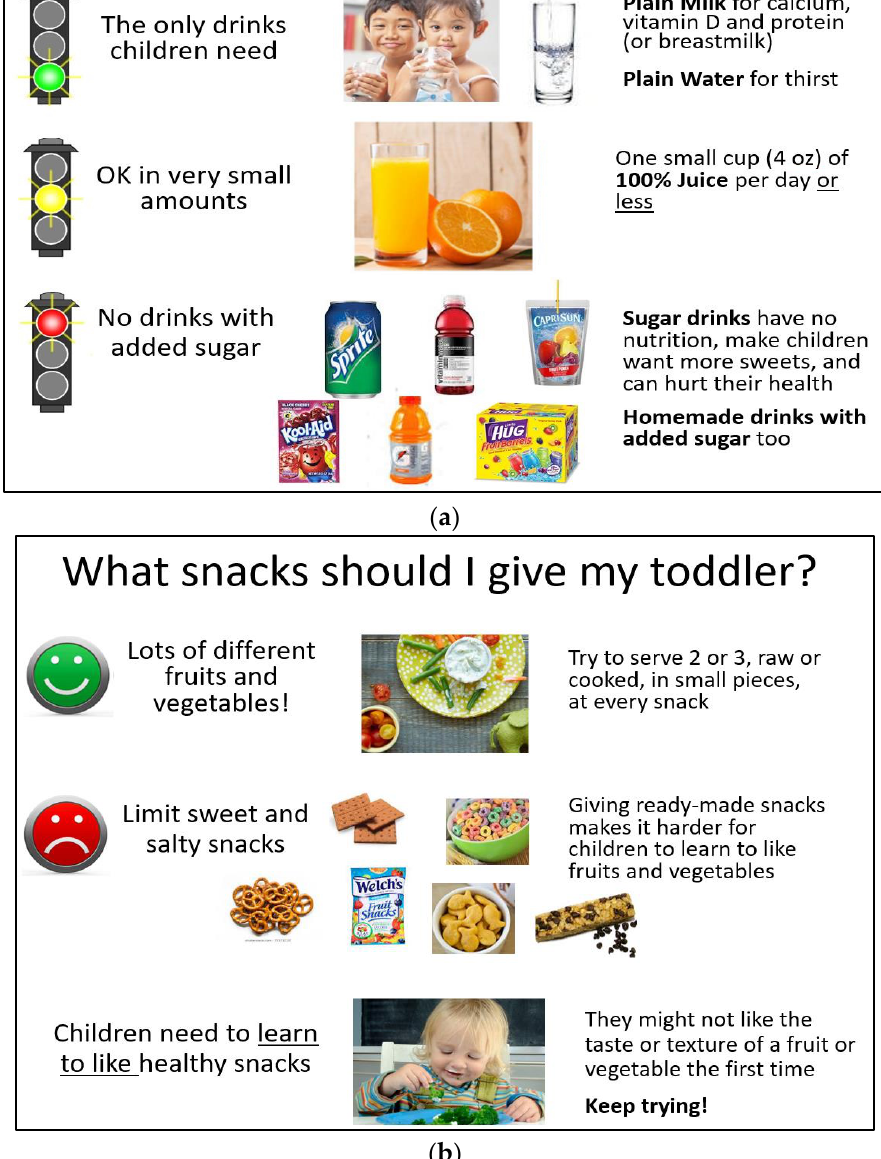
Figure A1. Stimuli presented in the focus groups: Expert recommendations for ( a ) drinks for toddlers; ( b ) snacks for toddlers.